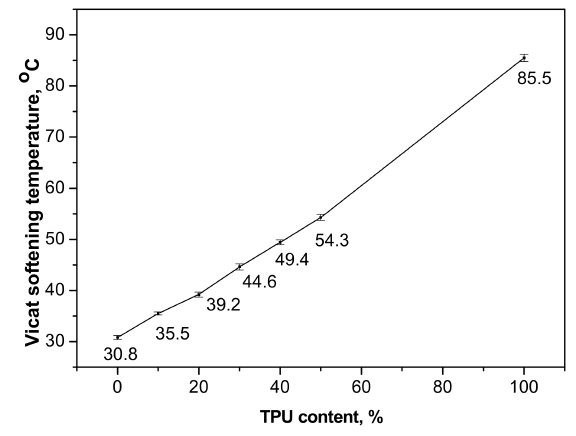
Figure 4. Effect of TPU content on Vicat softening temperatures of PPC/TPU